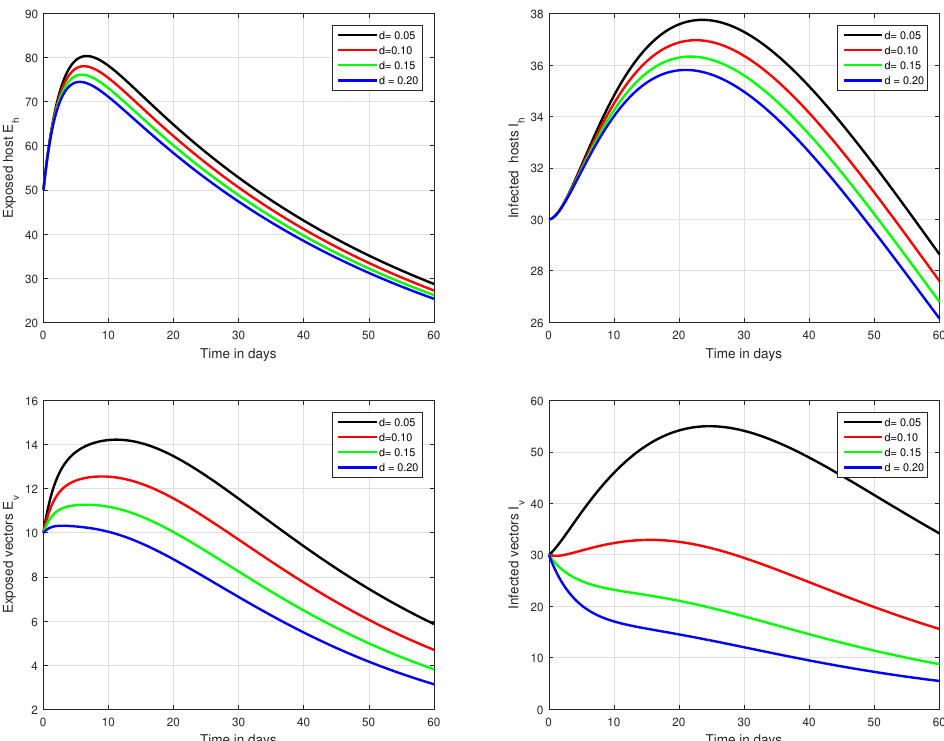
Figure 8. Illustration of the solution pathways of all the classes of our fractional model of Zika virus infection with various values of the input parameter d , i.e., d = 0.05,0.10,0.15,0.20.